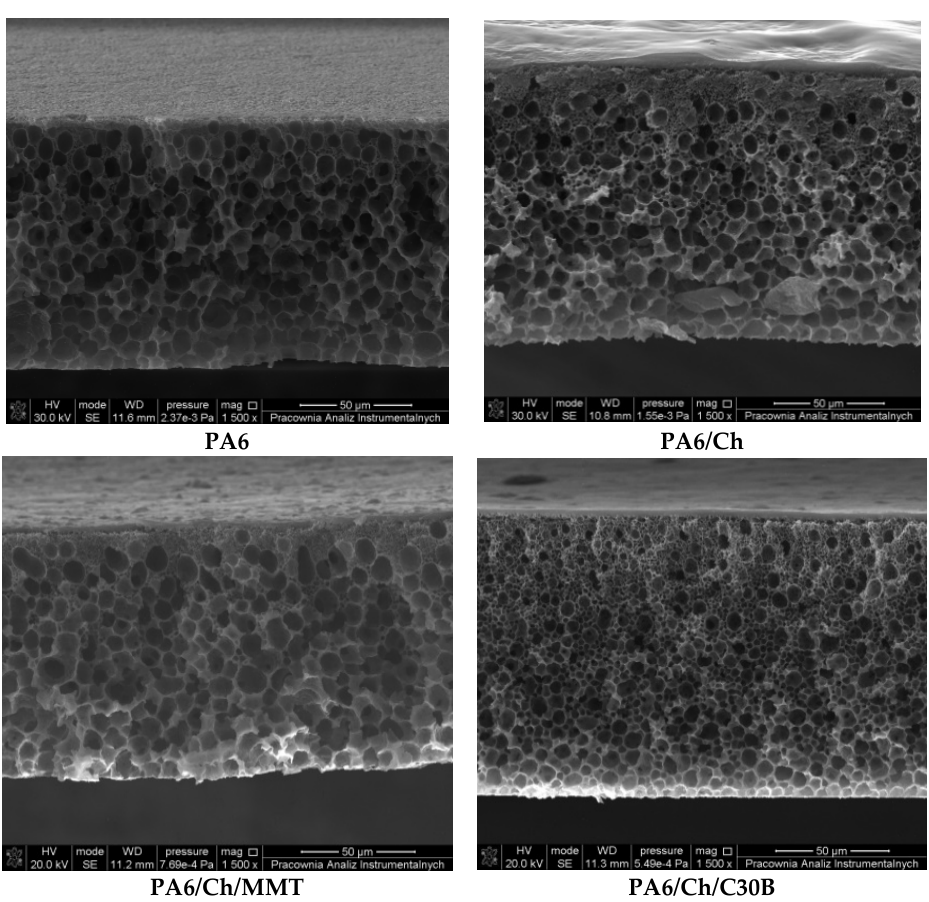
Figure 5. Morphology of cross‐section of the porous support and composite membranes with dense selective top‐layer.